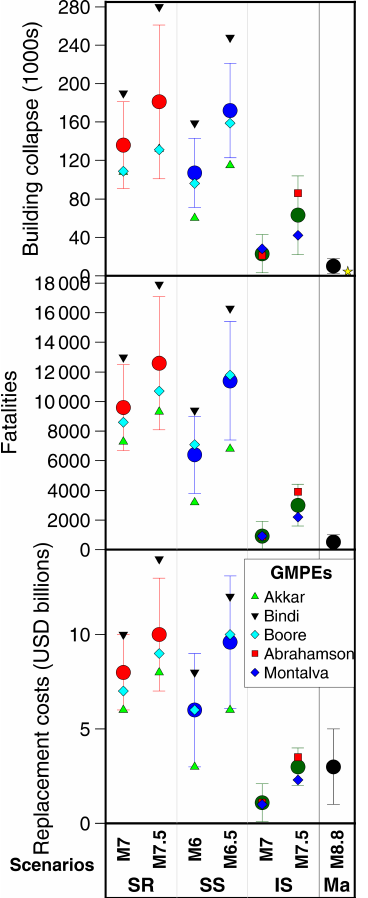
Figure 11. A summary of the total number of building collapses and fatalities as well as the total replacement costs for each sce- nario calculation. The solid circles are the average across the GM- PEs considered in each scenario, which are indicated by the smaller polygons. The spread in the estimates from the GMPEs indicates the epistemic uncertainty in our calculations. Error bars represent 1 standard deviation determined from the 1000 Monte Carlo simu- lations. The yellow star denotes the actual number of building col- lapses (4306) in Santiago in the 2010 Maule earthquake (Elnashai et al.,